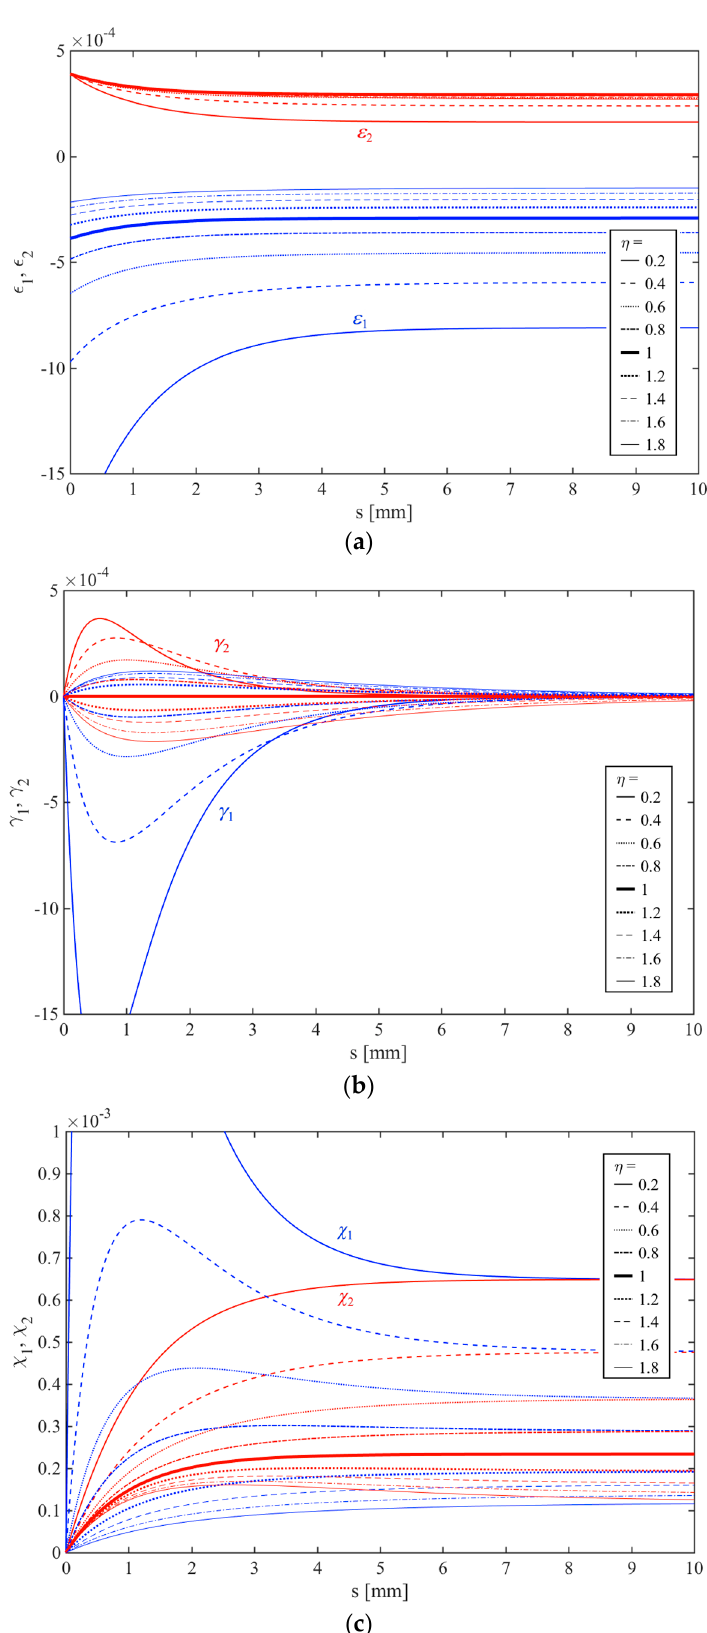
η Figure 15. Effect of the thickness ratio on the strain field: ( a ) Axial strain; ( b ) Shear strain; ( c ) Figure 15. Effect of the thickness ratio η on the strain field: ( a ) Axial strain; ( b ) Shear strain; Curvature. (Isotropic specimen). ( c ) Curvature. (Isotropic